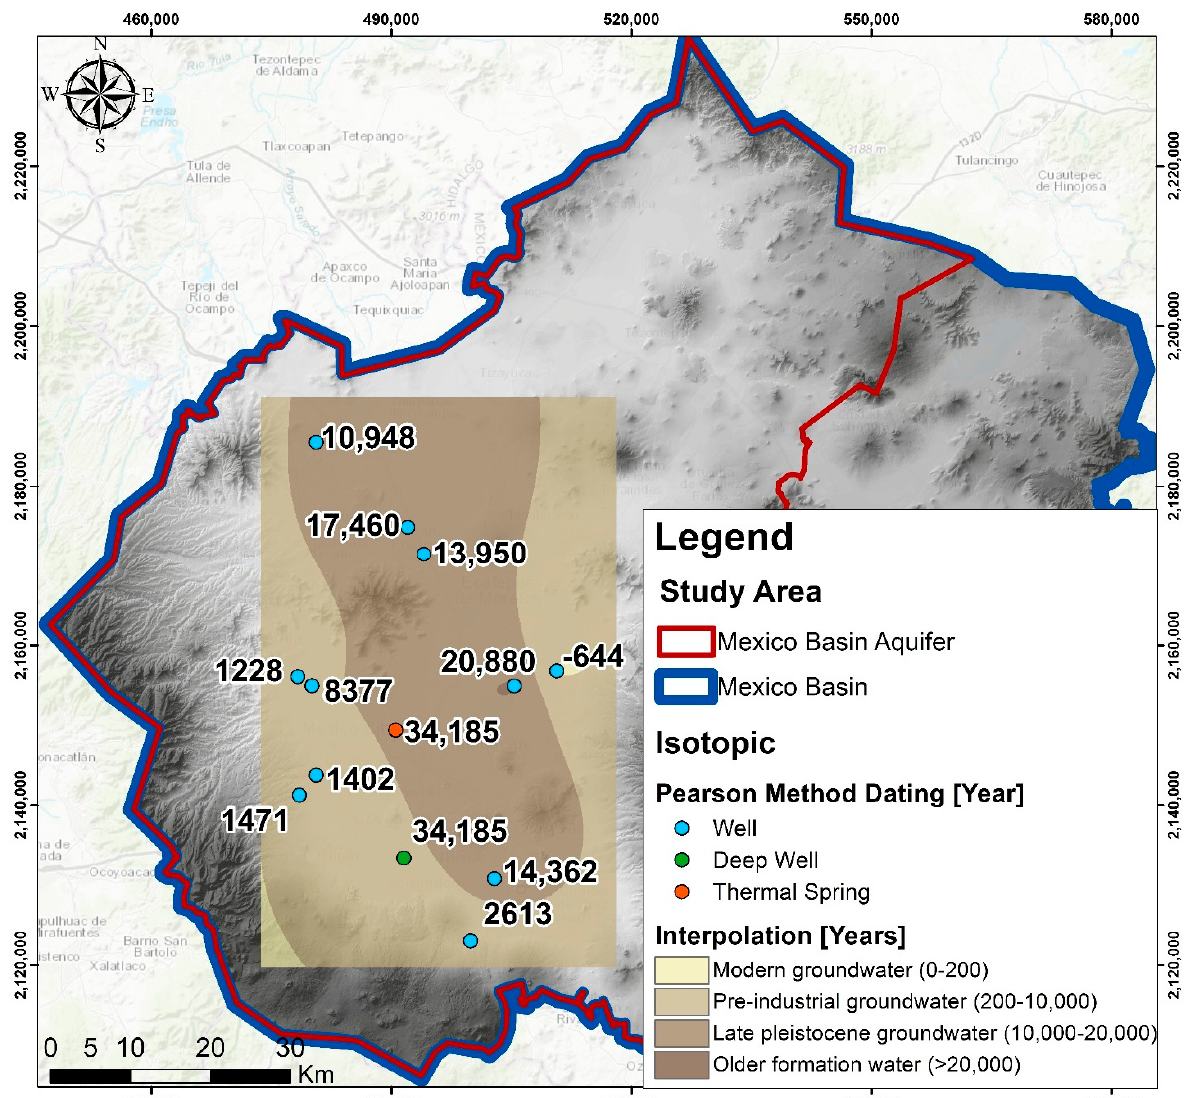
Figure 12. Groundwater age and classification.